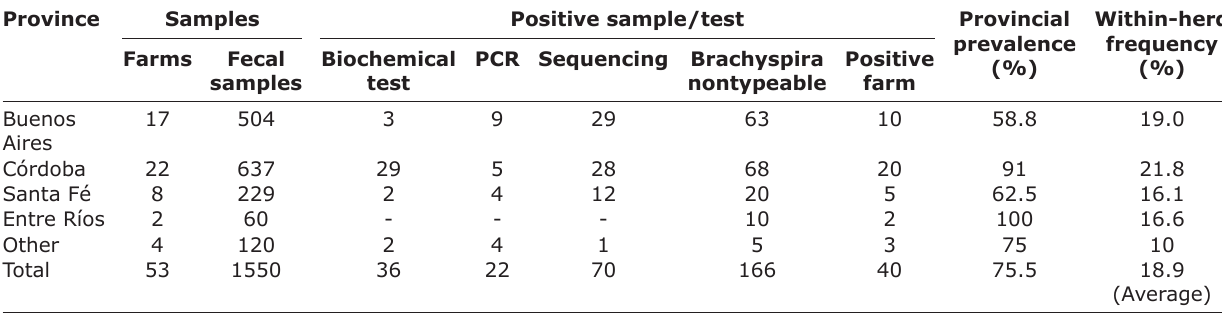
Table-1: Distribution of farms, samples taken, and prevalence of herds positive to Brachyspira spp. by province, positive samples for each diagnostic test, and frequency of Brachyspira spp. shedding pigs within-herd. Province